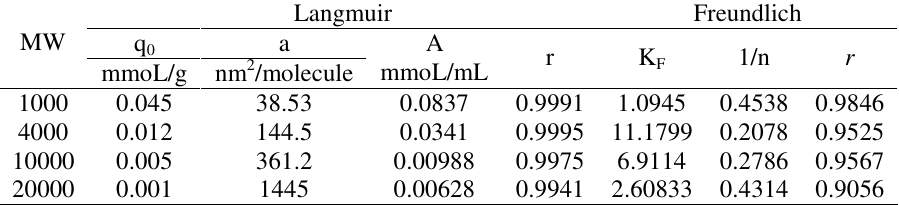
Table 3. Langmuir and Freundlich isotherm constants at 25 °C Langmuir Freundlich